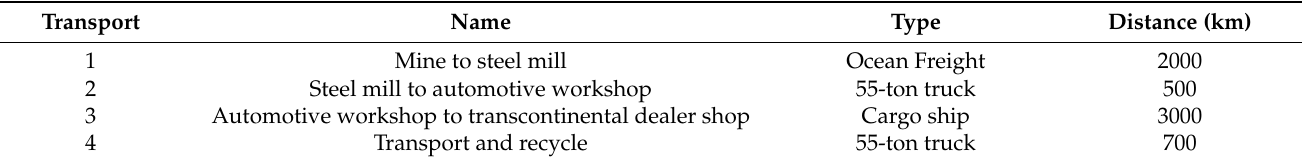
Table 2. Mobility conditions